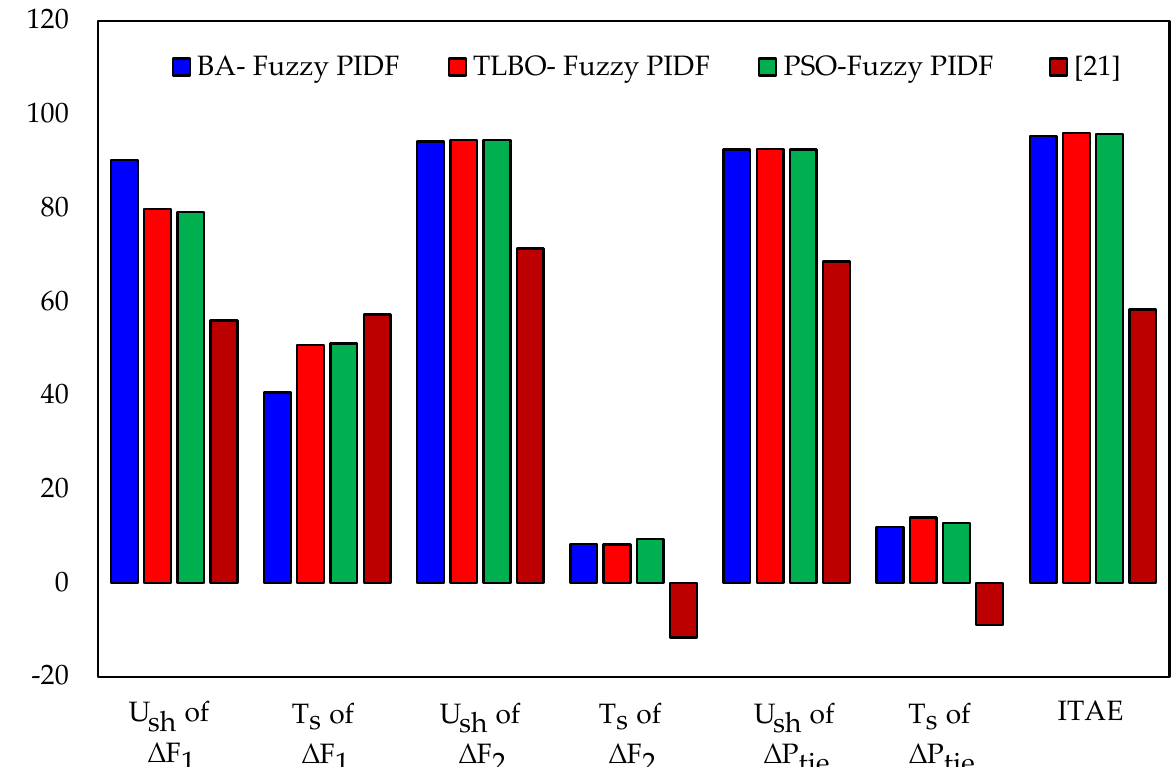
Figure 8. Percentage of improvement with different techniques.